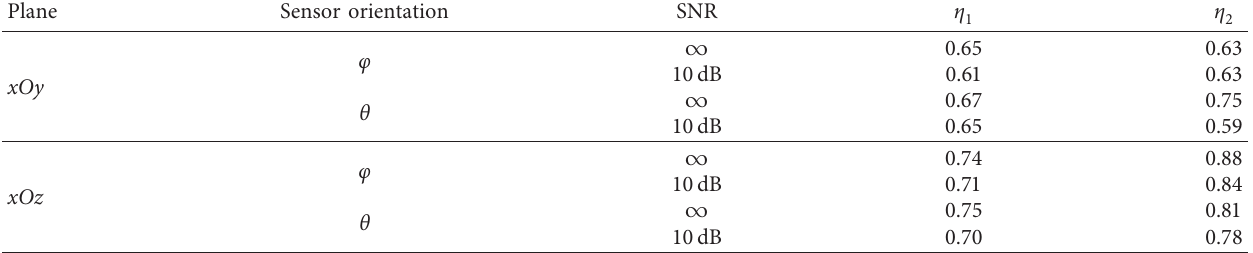
and η calculated for the cross-shaped dielectric target. 1 2